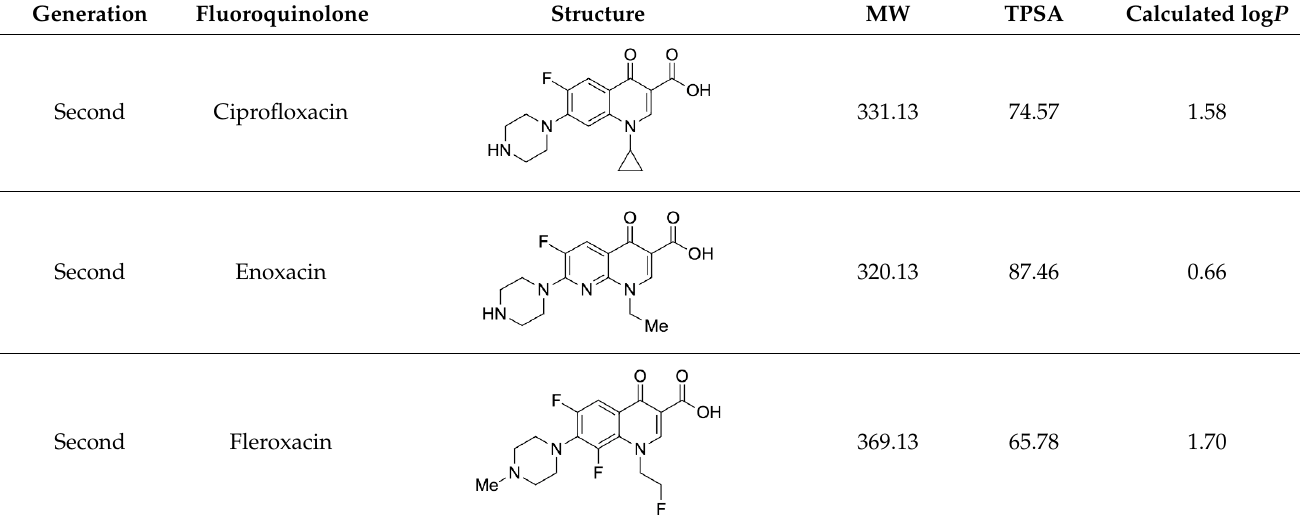
Table 1. Physicochemical properties of the fluoroquinolones studied in this manuscript. Generation